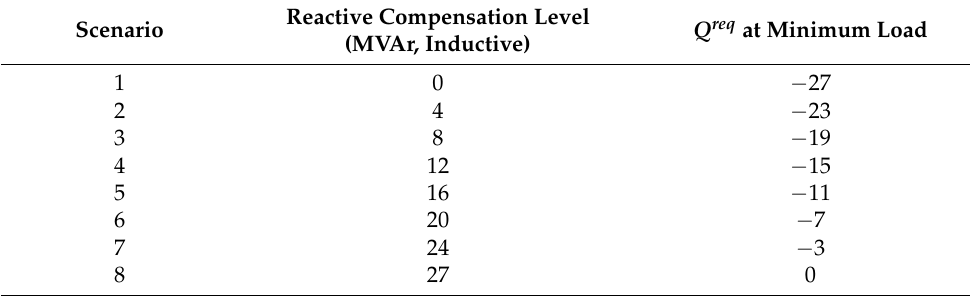
Table 1. Examined reactive compensation levels.